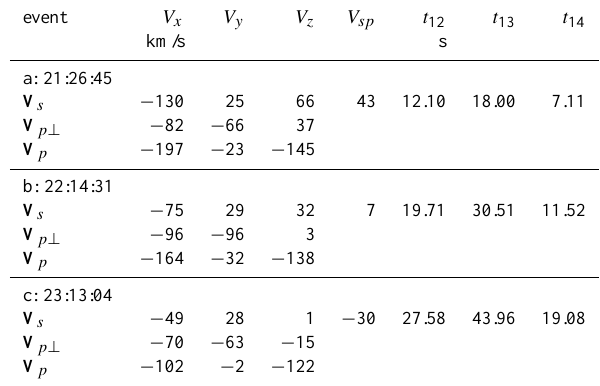
Table 2. Velocity of solitary structures V s and speed V sp com- puted with Eqs. (13) and (14) from signal delays derived from multi- spacecraft timing for three events in Fig. 6. The measured ion ve- locities, V p , and their perpendicular components V p ⊥ are shown for